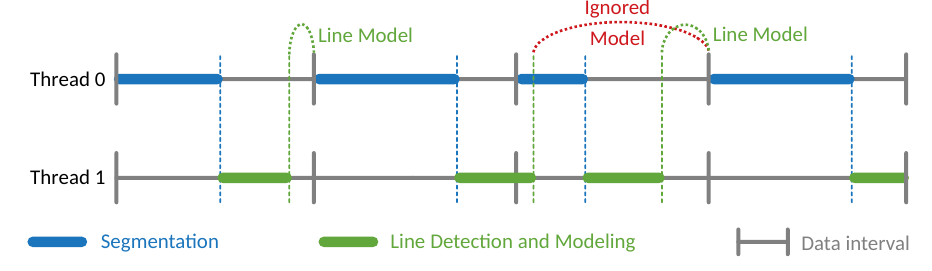
Figure 24. Effect of slow